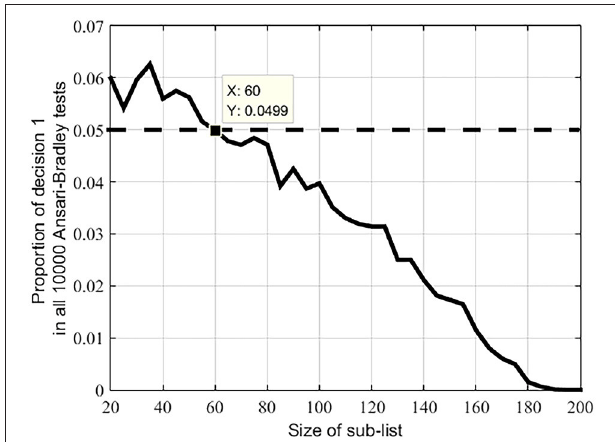
FIGURE 4 | Proportions of decision 1 in 10000 Ansari-Bradley tests under different sizes of sub-lists of the Swadesh 200-word list. Dotted line indicates the significance level